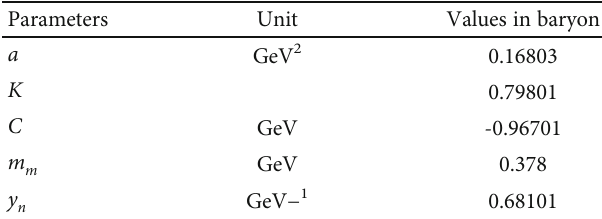
Table 2: The quark parameters for the instanton-induced interaction with the CDP